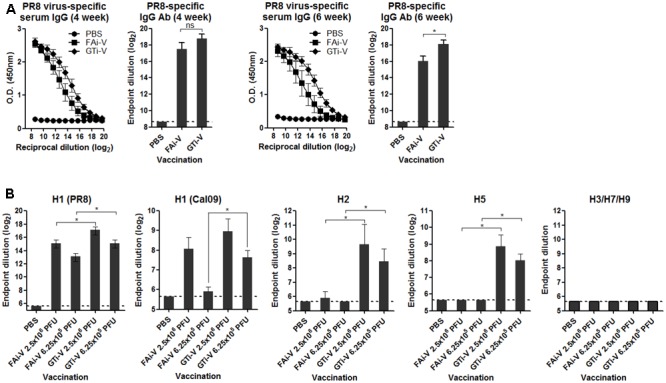
Antibody response to influenza virus and HA proteins. (A) Influenza virus-specific antibody responses. Twofold serial dilutions of antisera to FAi virus or GTi virus (vaccination dose; 2.5 × 106 PFU) were bound to PR8 virus (104 PFU/well) to measure the virus-specific IgG antibodies by ELISA. IgG antibody titers in sera obtained at 4 weeks post prime vaccination and 6 weeks post prime vaccination are shown. Antibody titers were expressed as the endpoint dilution that yielded OD450 greater than the mean +2 SD of PBS control group. The values are the mean of each cohort (n = 5). (B) HA-specific antibody responses. Twofold serial dilutions of antisera to FAi virus or GTi virus (vaccination dose; 6.25 × 105 PFU and 2.5 × 106 PFU) were bound to recombinant HA proteins to measure HA-specific IgG antibody titers by ELISA. The recombinant HA proteins tested include the homologous HA of PR8 (H1N1) and the heterologous HAs of A/California/6/2009 (H1N1), A/Canada/720/2005 (H2N2), A/Indonesia/5/2005 (H5N1), A/Sydney/5/1997 (H3N2), A/Anhui/1/2013 (H7N9), and A/Hong Kong/35820/2009 (H9N2). Antibody titers were expressed as the endpoint dilution that yielded OD450 greater than the mean +2 SD of the control group. The values are the mean of each cohort (n = 5). ∗P < 0.05 when comparing antibody titers between two different groups.